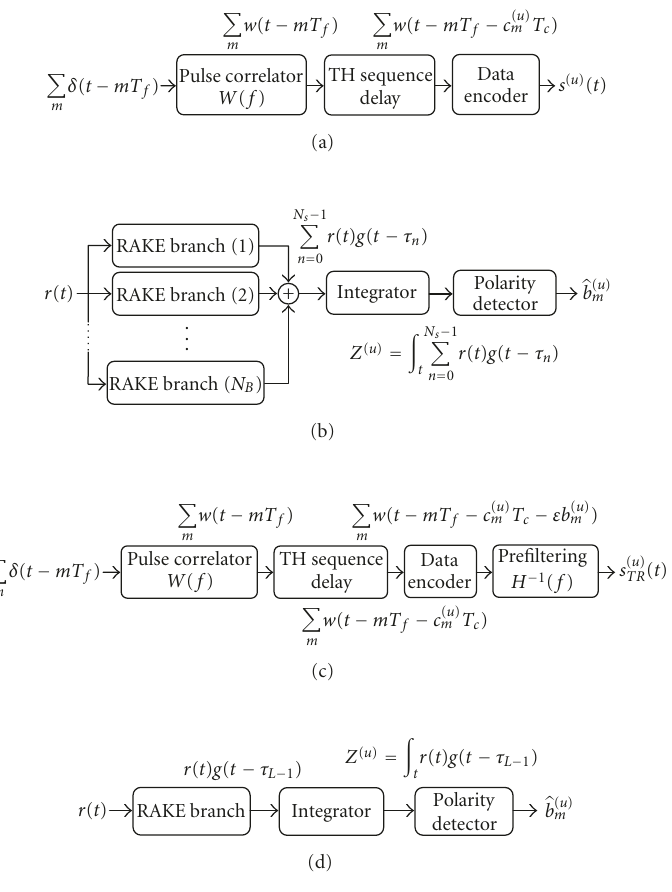
Figure 3: System model for (a) UWB transmitter, (b) UWB receiver, (c) TR-UWB transmitter, and (d) TR-UWB receiver.